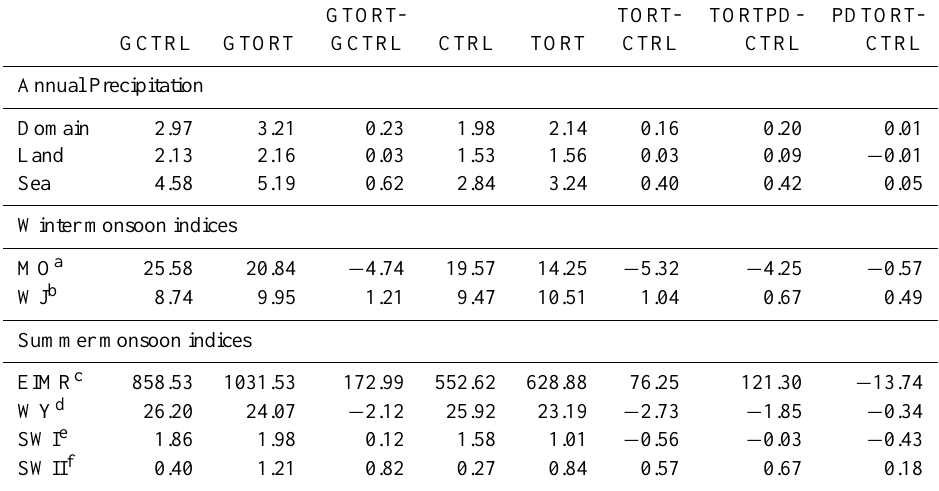
Table 3. The comparison of annual precipitation (mmday − 1 ), winter and summer monsoon indices between the global and regional model experiments. GTORT- TORT- TORTPD- GCTRL GTORT GCTRL CTRL TORT CTRL CTRL